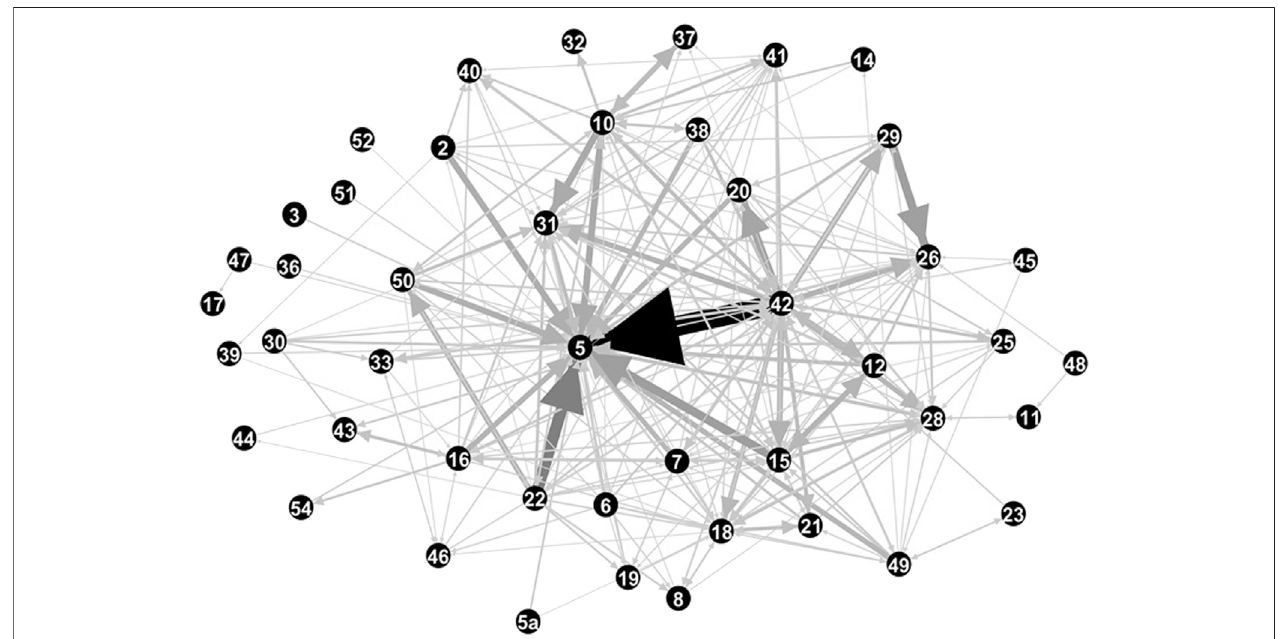
FIGURE2| Networkrepresentation ofcross-referencesat the titlelevel.Title 42 “ Public Health and Welfare ” has thelargest number ofoutgoingcitations, and Title 5 “ Government Organization and Employees ” has the most incoming